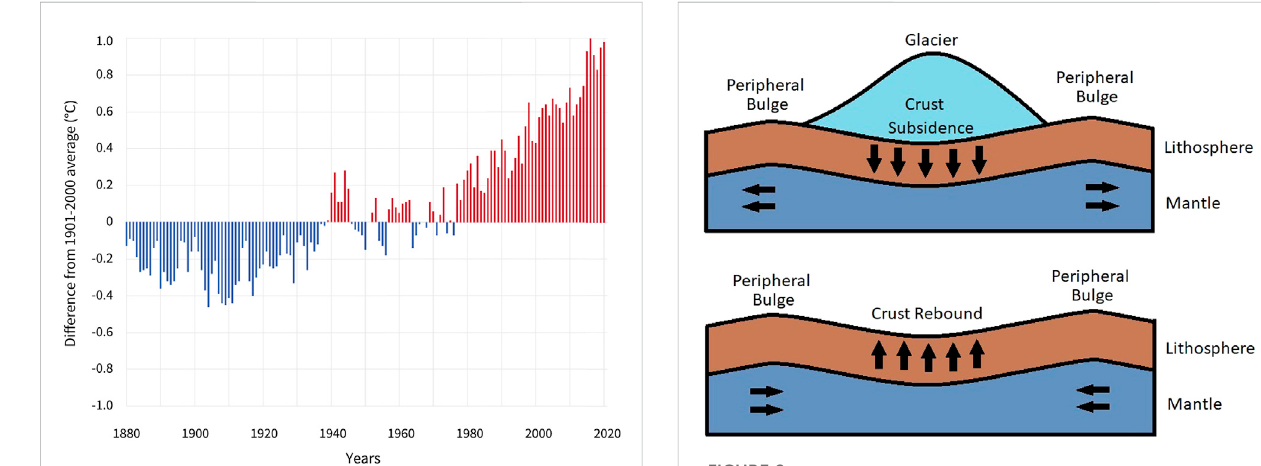
FIGURE 2 Effect of Glacier Melt on Earth ’ s